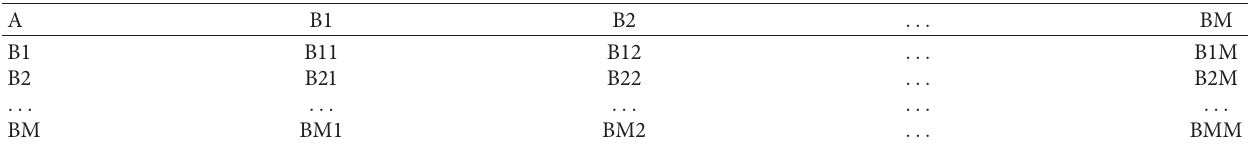
Figure 6: Evaluation index system diagram of rural network planning layout. Table 3: NXN order judgment matrix.